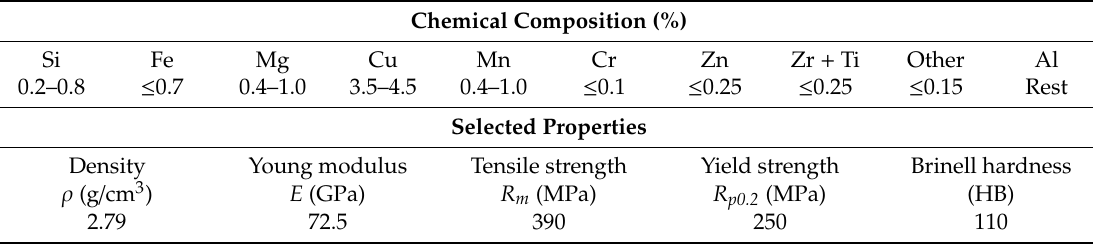
Table 1. The chemical composition and selected properties of the EN AW-2017A T451 alloy [26,27]. Chemical Composition